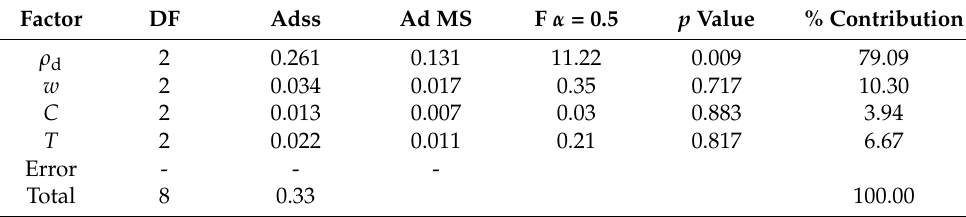
Table 5. ANOVA Analysis of GRA grade.